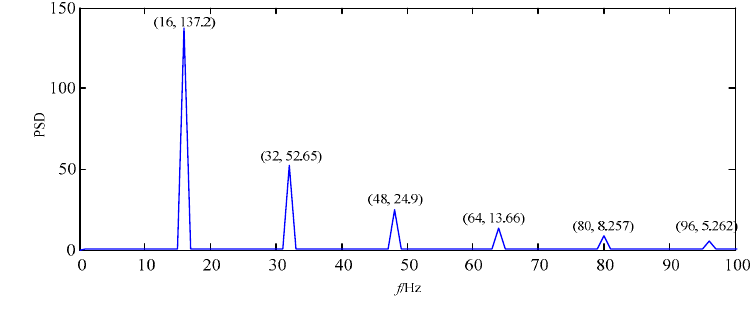
Figure 10. Power spectrum density of F 2 .